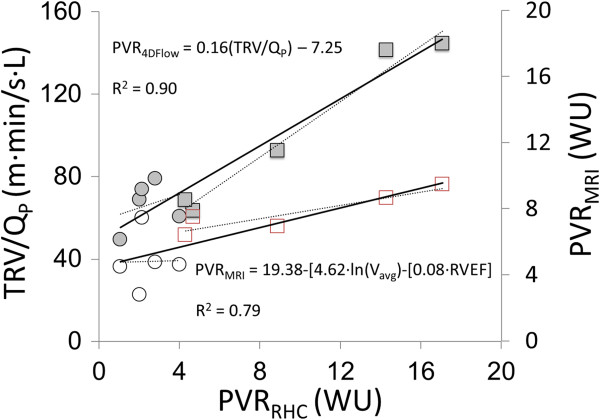
Derivation of PVRMRI equation from the linear regression between TRV/ QP and PVRRHC (PVRMRI = 0.16(TRV/ QP) – 7.25).